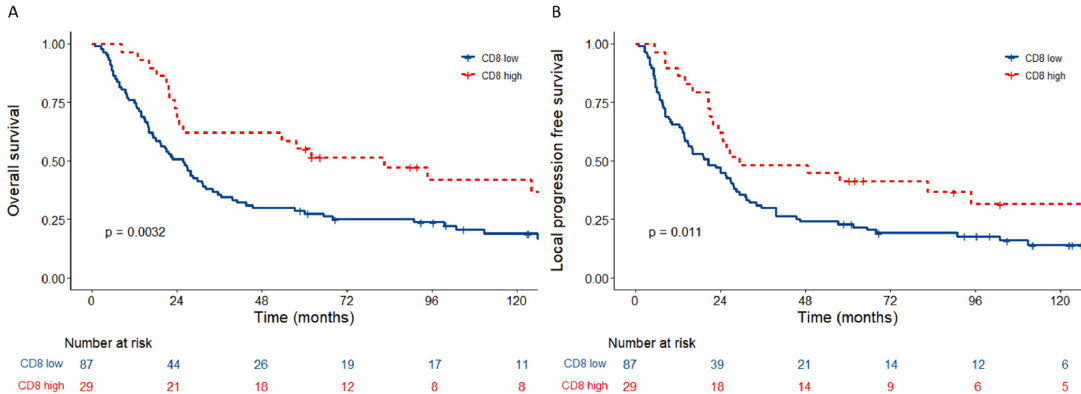
Figure 1. Kaplan–Meier plots of survival according to percent CD8 . p values are from log-rank tests calculated by R packages “survival” and “survminer”. CD8 T cells are stratified into low and high using the upper quartile as the cut-off. ( A ) Overall survival and ( B ) local progression free survival in the whole cohort according to percent CD8 T cells low vs. percent CD8 T cells high for 16-year follow-up data.